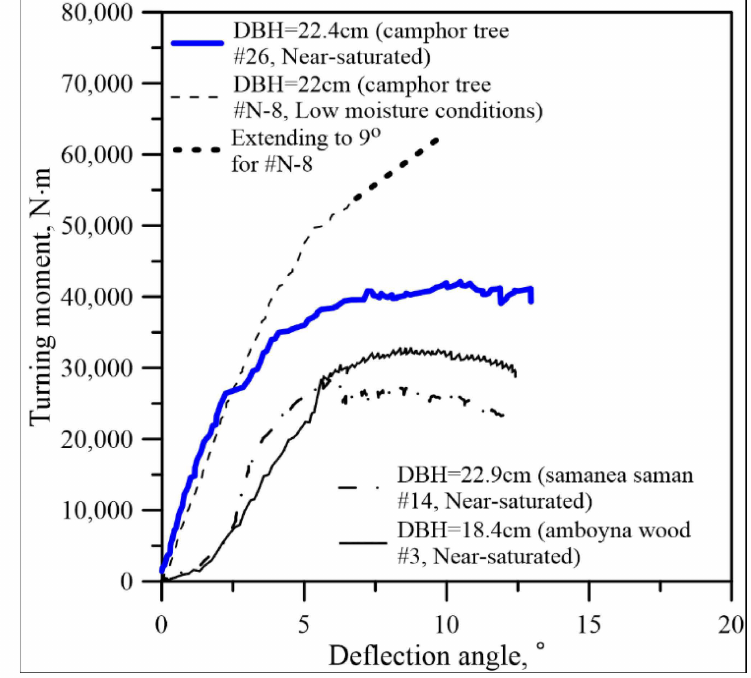
Figure 2. Experimental relationship of the turning moment vs. the deflection angle of the trees.